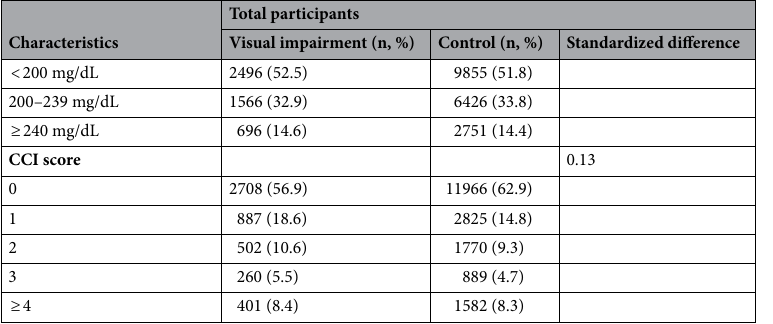
Table 1. General characteristics of participants at baseline. CCI, Charlson comorbidity index. *Chi- square test. Significance at P < 0.05. † BMI groups (BMI, body mass index, kg/m2) was categorized as < 18.5 (underweight), ≥ 18.5 to < 23 (normal), ≥ 23 to < 25 (overweight), ≥ 25 to < 30 (obese I), and ≥ 30 (obese II).